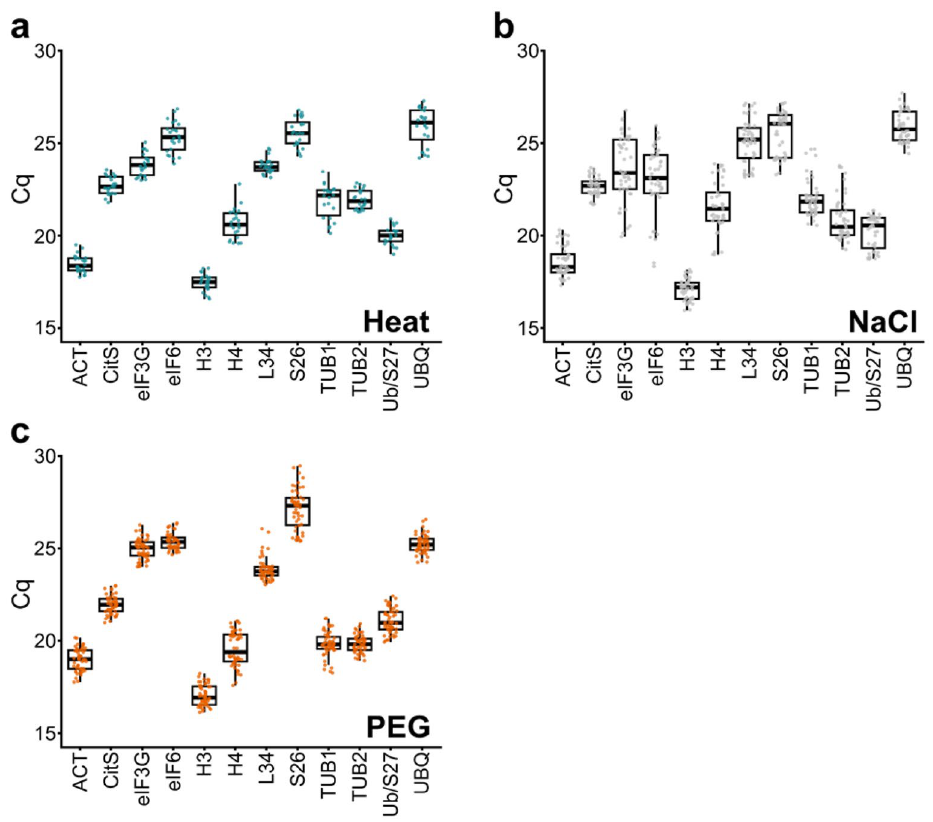
Figure 1. Quantification cycle (Cq) variation of candidate reference genes in each stress condition. Each value of Cq from control and stress samples is represented by a dot. Box indicates the 1st and 3rd quartiles, the ends of vertical line represent the maximum and minimum values. The horizontal line through the box represents the median. Cq from control and stressed samples after: ( a ) 5 and 10 of heat shock at 45 °C, then 30 min at 20 °C, ( b ) salt stress with 500 mM NaCl during 1, 3 and 6 h and ( c ) PEG-induced dehydration at 15 and 30% (w/v) during 1, 3 and 6